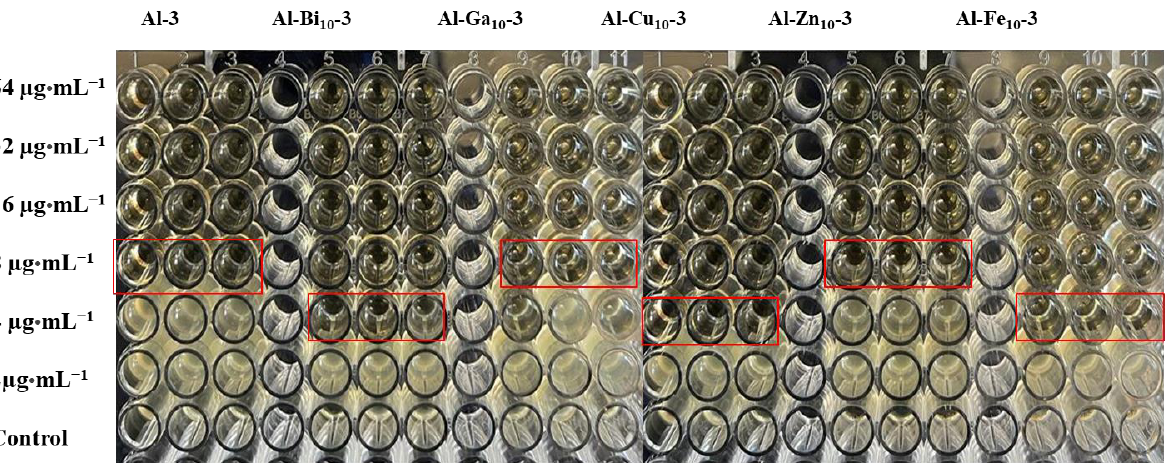
Figure 8. Photographs showing the MIC measurements for Al 2 O 3 , Al-Cu 10 - 3 , Al-Zn 10 -3, Al-Fe 10 -3, Al-Bi 10 -3, and Al-Ga 10 -3 (MIC values are marked in the red box) against Pseudomonas aeruginosa.